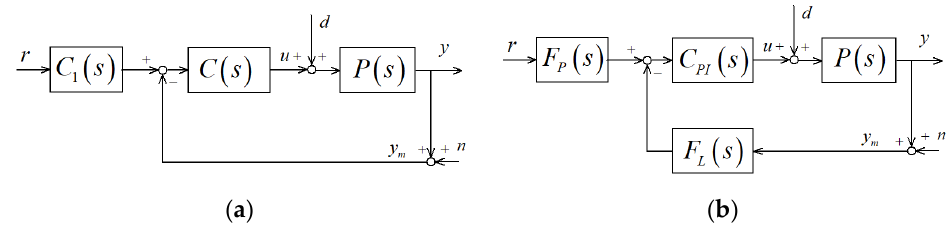
Figure 2. The blocks of FOLADRC ( a , b ). Figure 2b is the new block diagram provided by this paper. It illustrates the